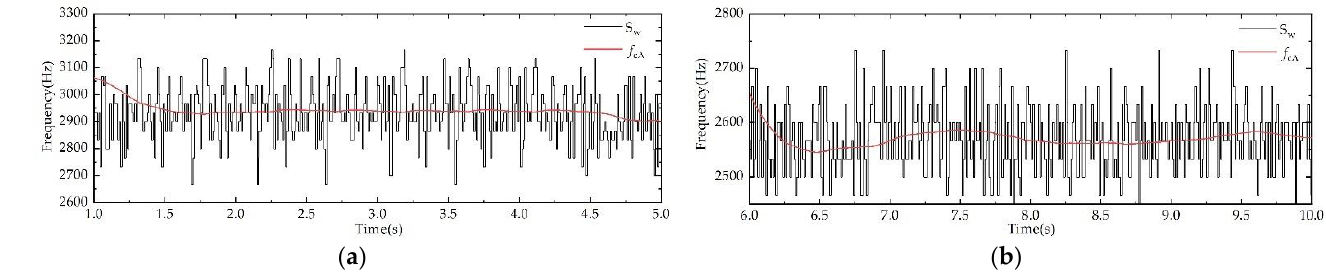
Figure 18. Switching frequency of FCS-MPC and calculated value of ASOGI center frequency: ( a ) At the load of 7 N·m; ( b ) At the load of 14 N·m.